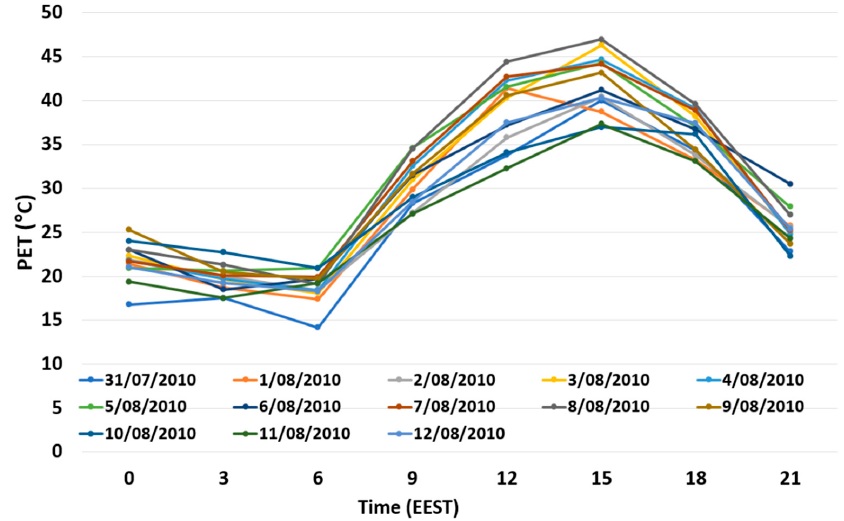
Figure 6. Daily course of PET values in the period from 31 July to 12 August 2010 using the example of Kyiv.